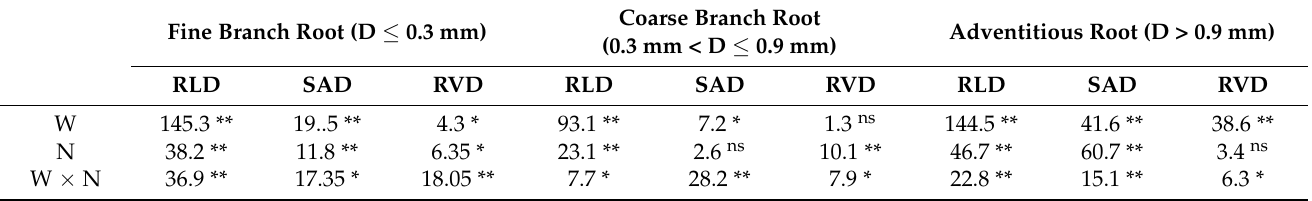
Table 4. Analysis of variance for the morphology of the rice root system under drip irrigation